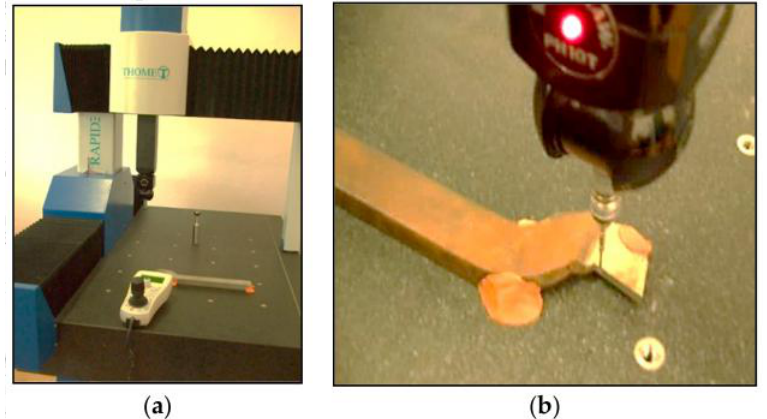
Figure 3. Preliminary tests of input angles of tool orthogonal rake γ o , ( a ) Overall view on the testing equipment RAPID CNC THOME, ( b ) Detail view on the measuring of a tool orthogonal rage angle.